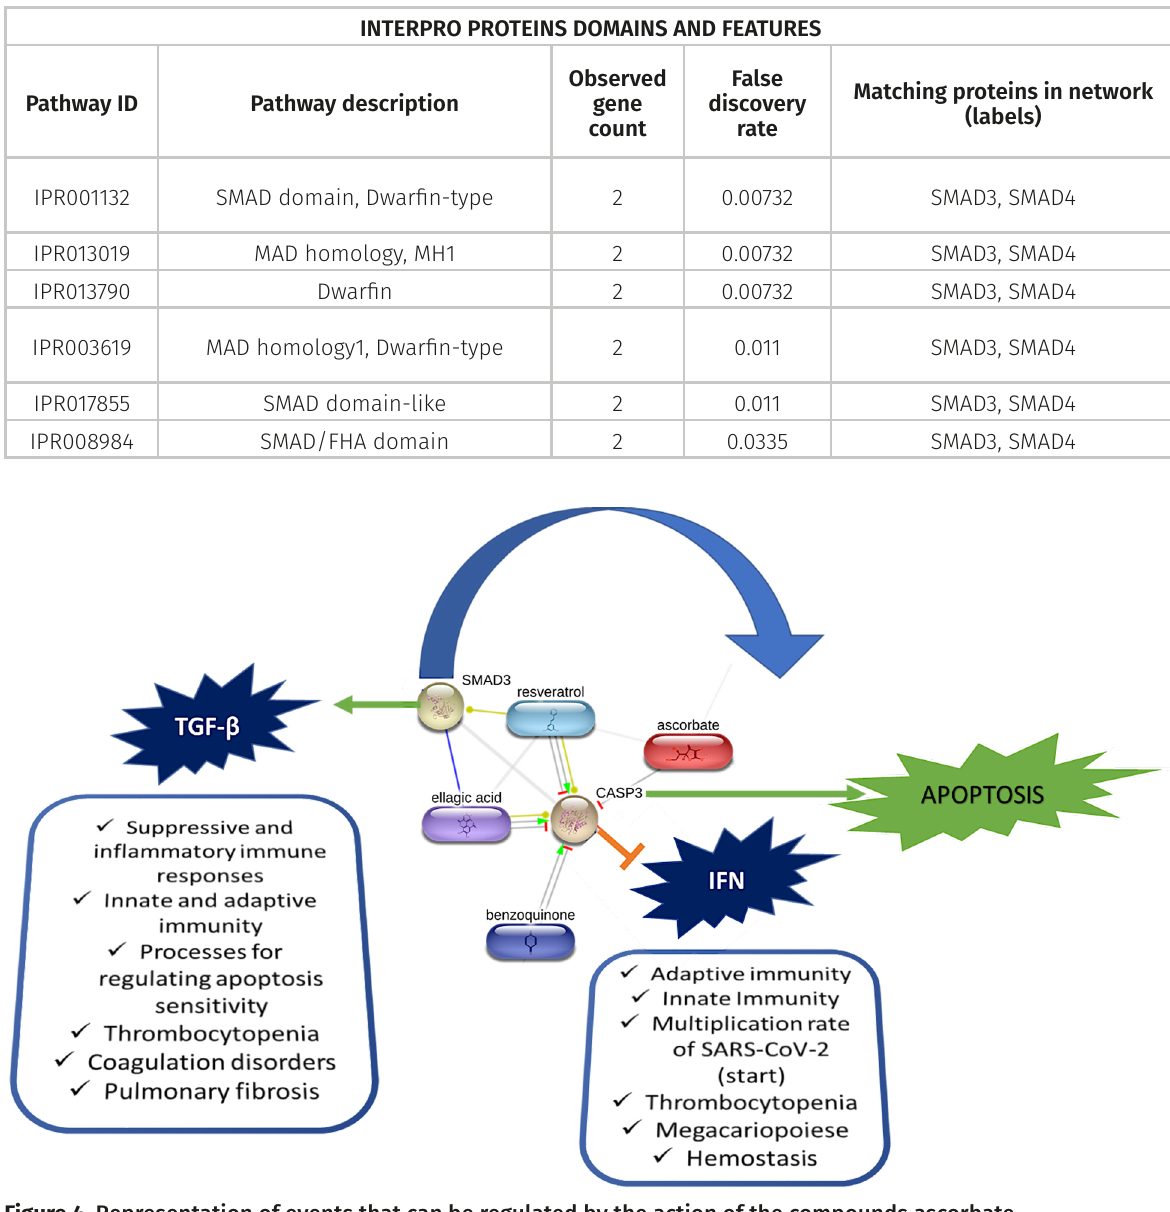
Table III. Continuation.